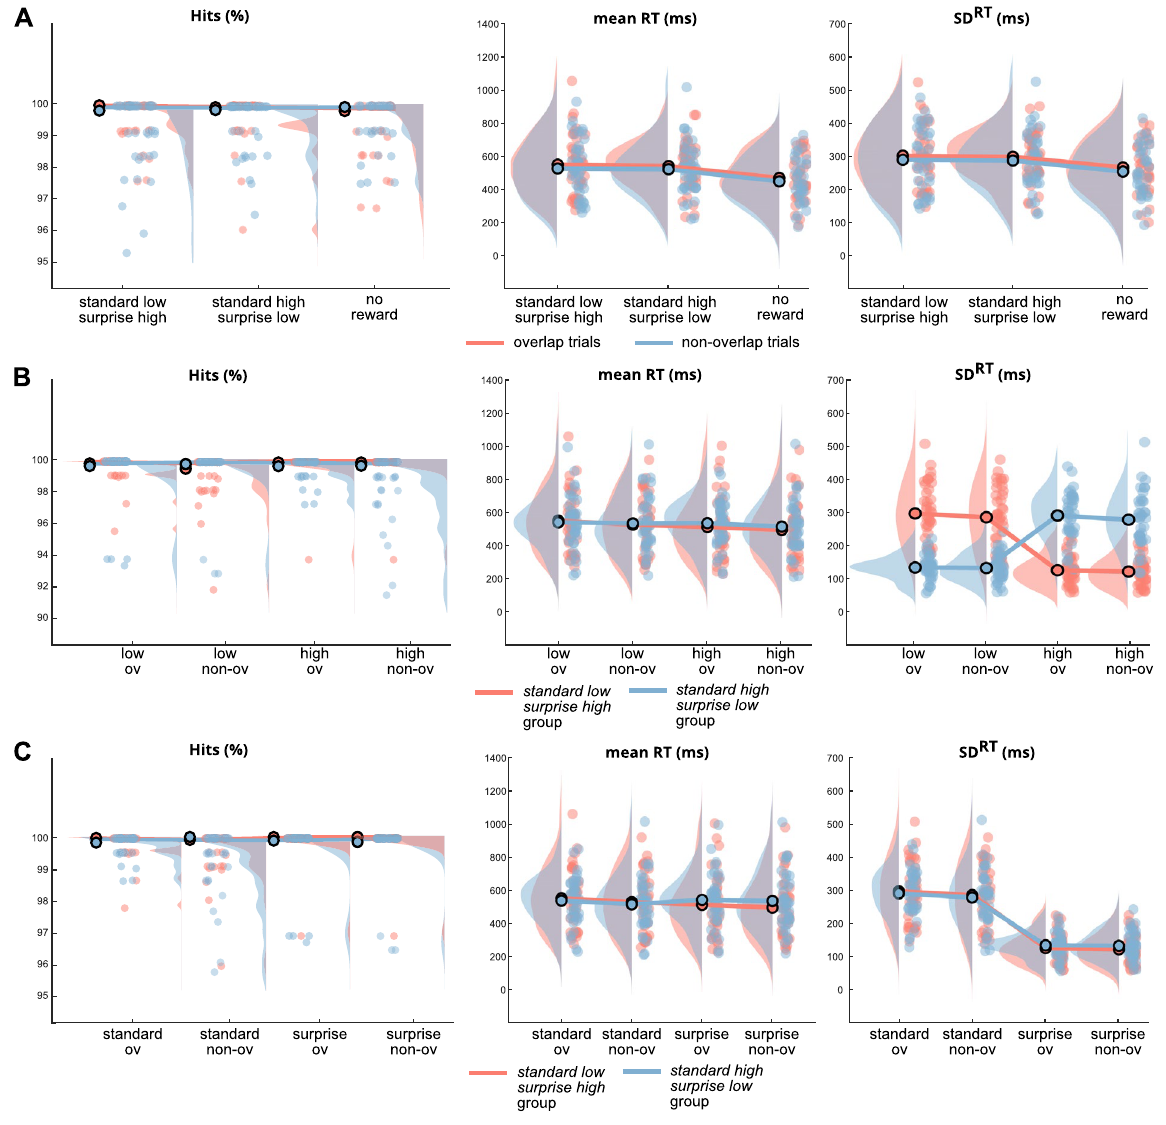
Figure 2. Raincloud scatter plots for accuracy (hits in %), mean RT in ms and standard deviation of RT in ms (SD RT ) data. The central dot denotes the mean value. ( A ) Comparison of standard low—surprise high, standard high—surprise low and no reward group. The overlap condition is denoted in red color, the non-overlapping condition in blue colors. ( B ) Overlapping versus non-overlapping condition data separated by low and high reward condition. Data for standard low—surprise high group is denoted in red colors, data for standard high— surprise low in blue colors. ( C ) Overlapping versus non-overlapping condition data separated by standard and surprise condition. Data for standard low—surprise high group is denoted in red colors, data for standard high—surprise low in blue